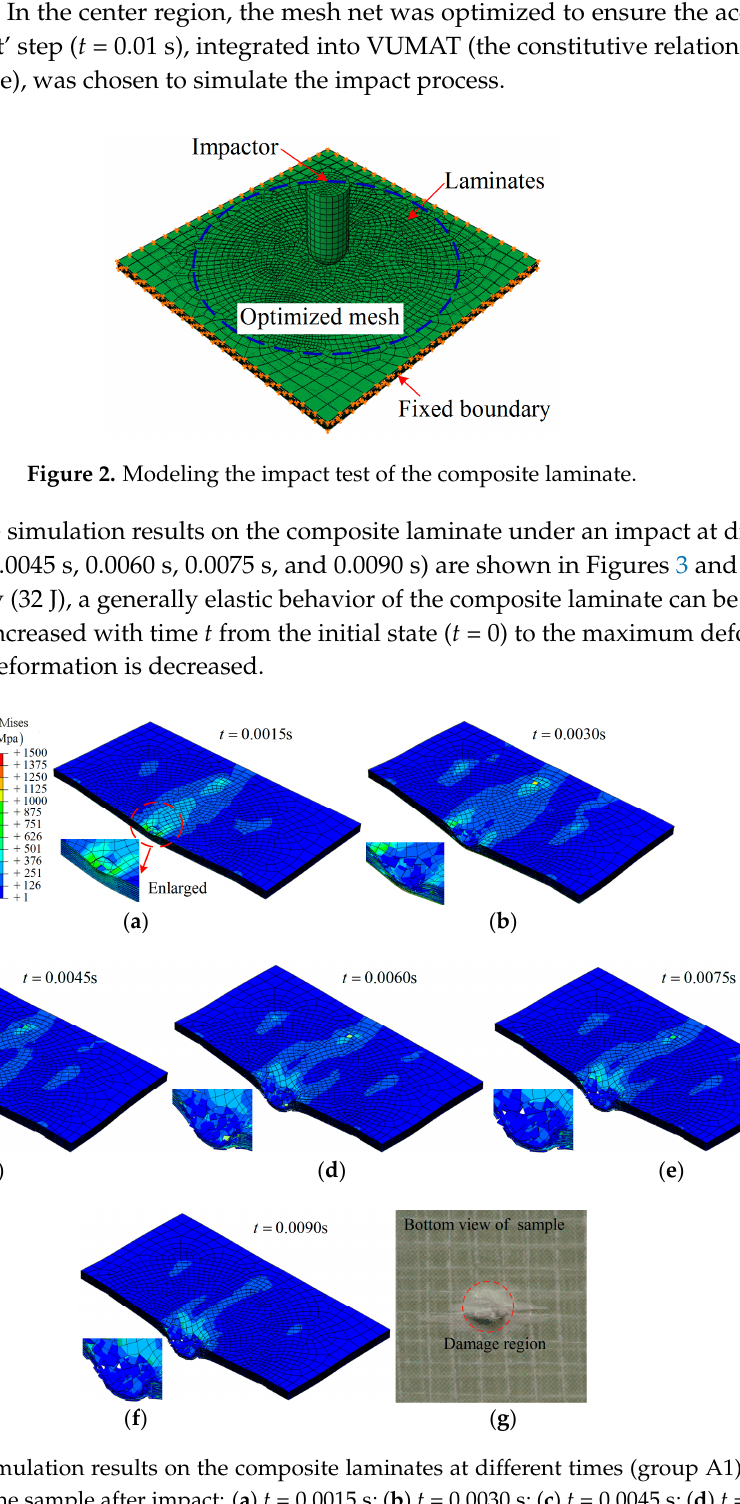
Figure 3. The simulation results on the composite laminates at different times (group A1), and the bottom view of the sample after impact: ( a ) t = 0.0015 s; ( b ) t = 0.0030 s; ( c ) t = 0.0045 s; ( d ) t = 0.0060 s; ( e ) t = 0.0075 s; ( f ) t = 0.0090 s; ( g ) bottom view of sample.